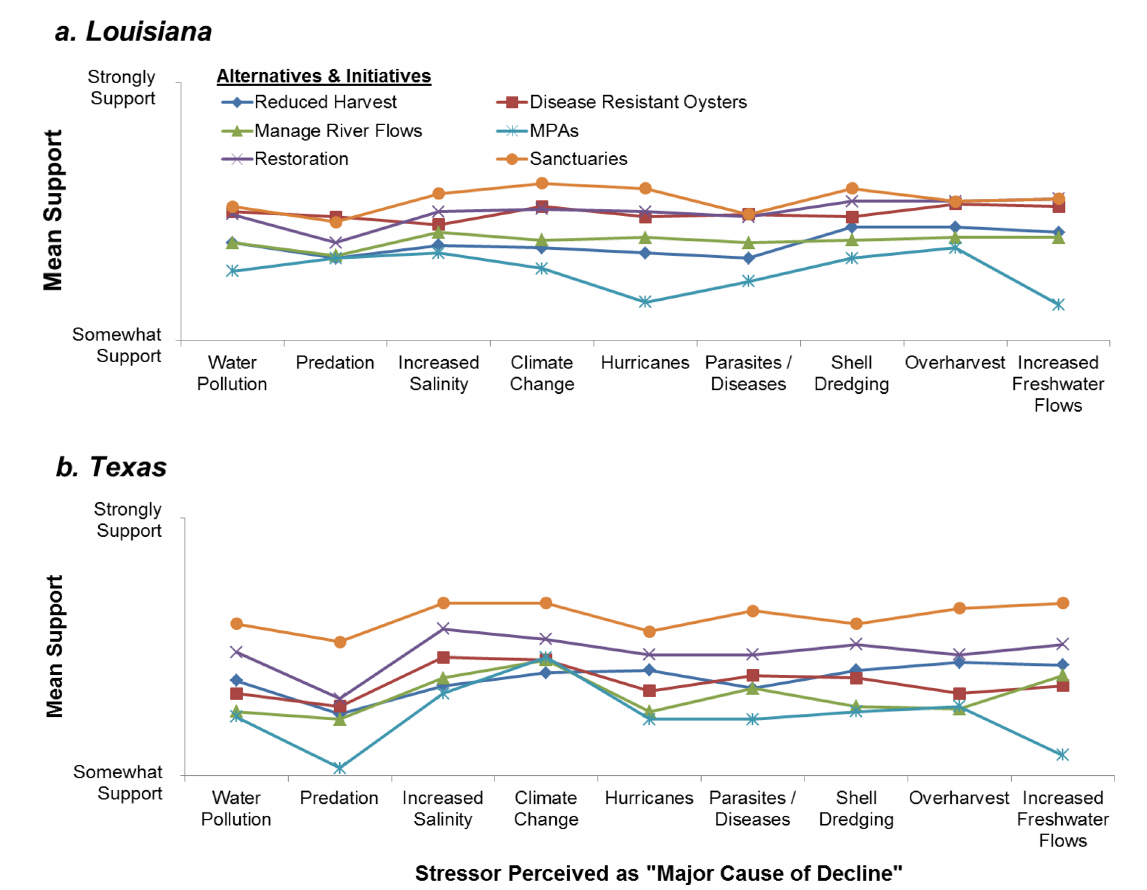
Fig. 4 . Support of stewardship initiatives across each stressor perceived to be a major cause of decline for Louisiana (a) and Texas (b) oysters. All of the shown stressors and initiatives were asked as individual questions; therefore, individual survey participants may fall in multiple